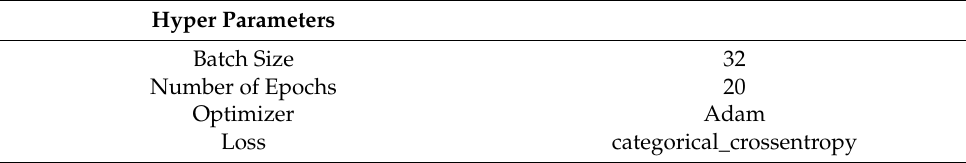
Table 2. Experimental